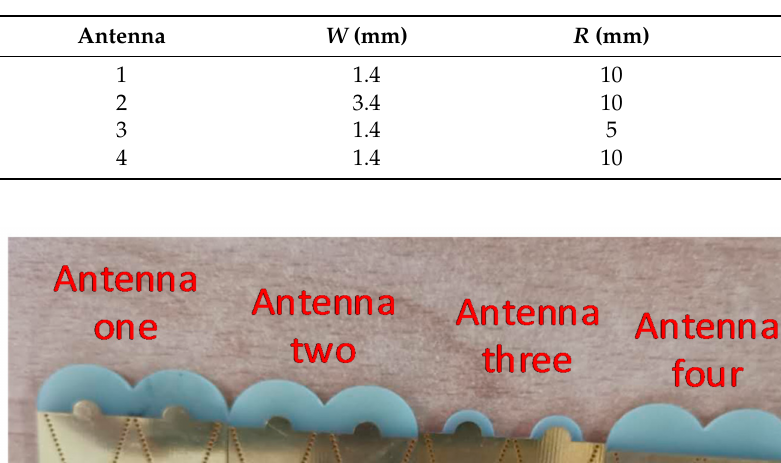
Table 3. Parameter table.